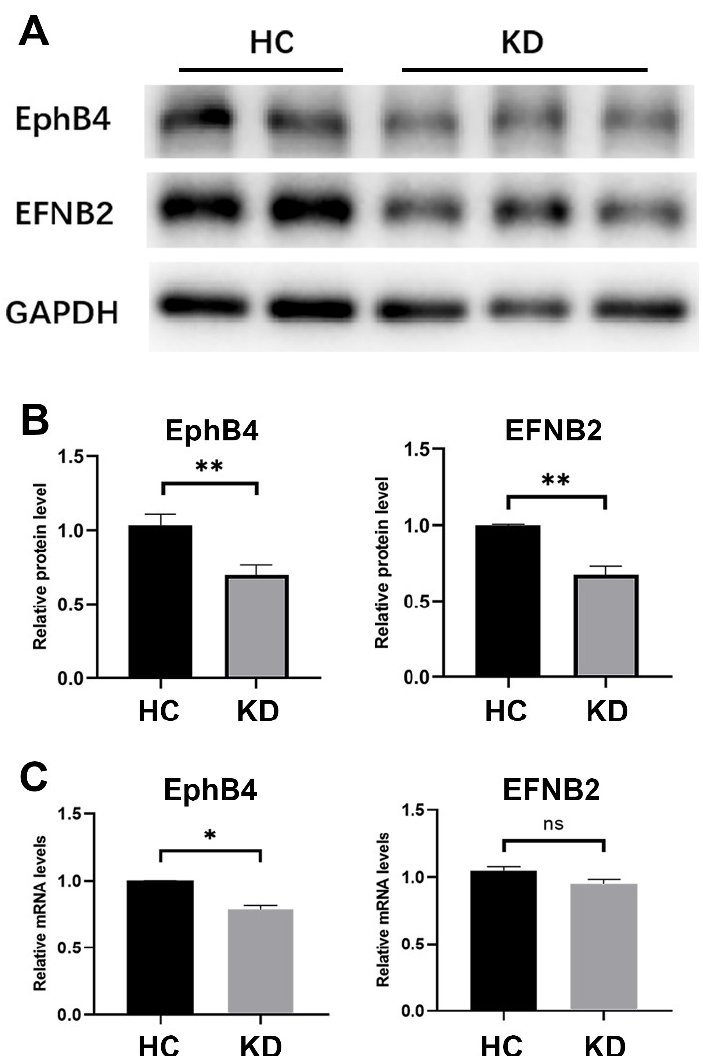
Figure 2. Expression of EphB4 and EFNB2 in the cell model of KD. HCAECs were incubated in a medium containing 15% sera from HCs or KD for 6 hours. ( A , B ) Protein levels of EphB4 and EFNB2 were measured by Western blot. ( C ) The mRNA expressions of EphB4 and EFNB2 were measured by RT-qPCR. All results are expressed as the mean ± SEM. * p < 0.05, ** p < 0.01 versus the control group. 2.3. EphB4 Inhibition Promoted Cell Migration and Attenuated Cell Angiogenesis Ability Endothelial cell migration and proliferation are key processes in the repair and aggra- vation of vascular injury. To determine the functional significance of low EphB4 expression in KD, EphB4 was knocked down with specific siRNA targeting EphB4. Meanwhile, siCtrl was transfected into cells as a control group to eliminate the interference of transfection reagent and RNA on cells. After 24 h of knockdown, a linear scratch was made in HCAECs, and the medium was changed with basic ECM. The result indicated that EphB4 knockdown in HCAECs increased cell migration within 6 h ( n = 4, paired Student’s t -test, p < 0.01) (Figure